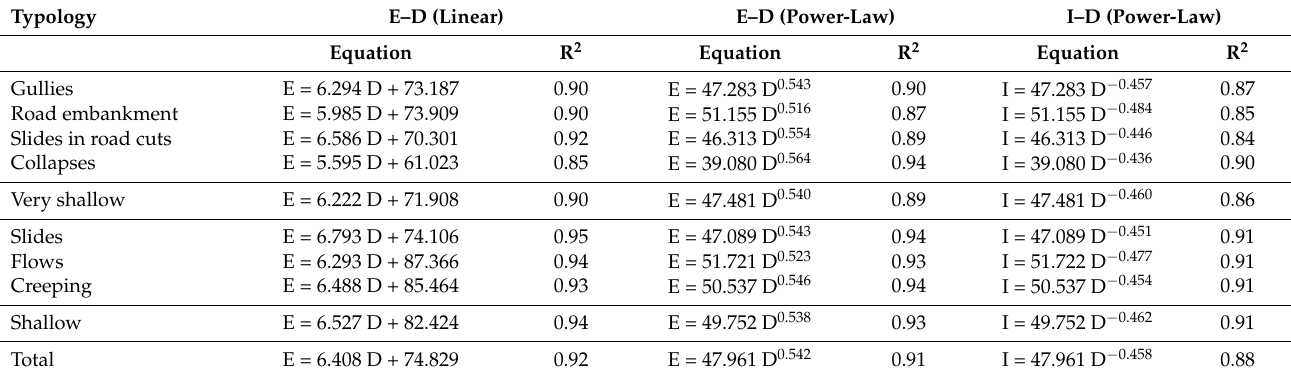
Table 6. Equations for E–D (linear and power-law) and I–D